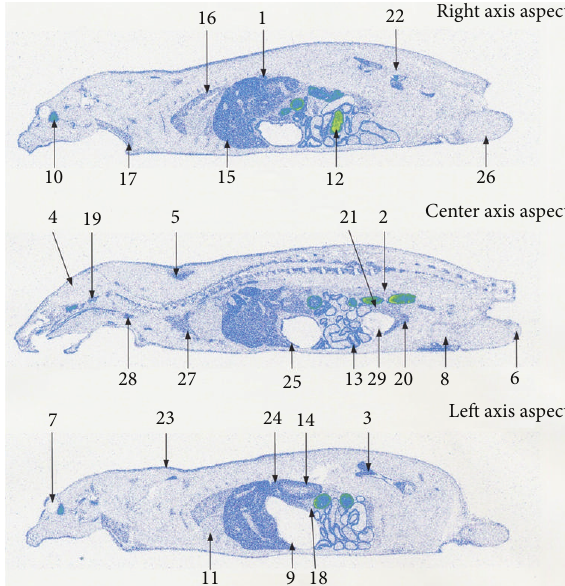
Figure 4: Whole body radioluminograms 96 hours after single oral administration of 14 C hyaluronic acid to a rat (dose: 25 mg/kg). (1) Adrenal gland. (2) Blood. (3) Bone marrow. (4) Brain. (5) Brown fat. (6) Epididymis. (7) Eyeball. (8) Fat. (9) Gastric contents. (10) Harderian gland. (11) Heart. (12) Intestinal contents. (13) Intestine. (14) Kidney. (15) Liver. (16) Lung. (17) Mandibular gland. (18) Pancreas. (19) Pituitary gland. (20) Prostate gland. (21) Seminal vesicle. (22) Skeletal muscle. (23) Skin. (24) Spleen. (25) Stomach. (26) Testes. (27) Thymus. (28) Thyroid gland. (29) Urine in